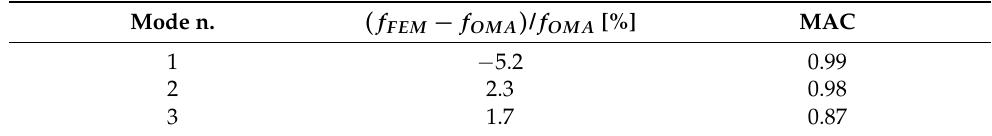
Table 3. Comparison of numerical and experimental modal